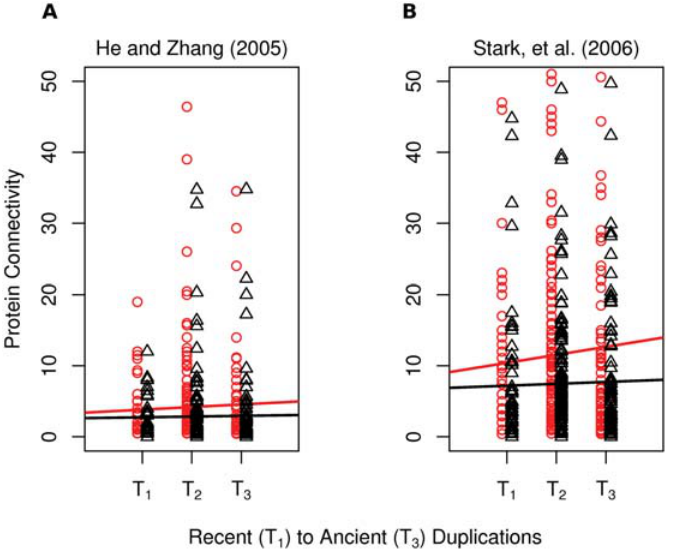
Figure 6. Change in the number of interacting partners (protein connectivity) over time. Proteins are aligned with the phylogenetic period from Figure 5 in which they were born (see Methods). Red circles identify the connectivity of gene duplicates born at the indicated phylogenetic timepoint: T 1 , T 2 , and T 3 . The red trend line indicates that the connectivities of gene duplicates increase over time. Black triangles identify the same proteins after removing interactions with more recent duplicates. The black trend line indicates that once subsequent duplications are accounted for, the connectivities of paralogous genes remain largely unchanged. This is consistent with the alternate explanation proposed in Figure 4B. (A) The combined interaction datasets [29,30] used by He and Zhang [6]. (B) Physical interactions from BioGrid [31].